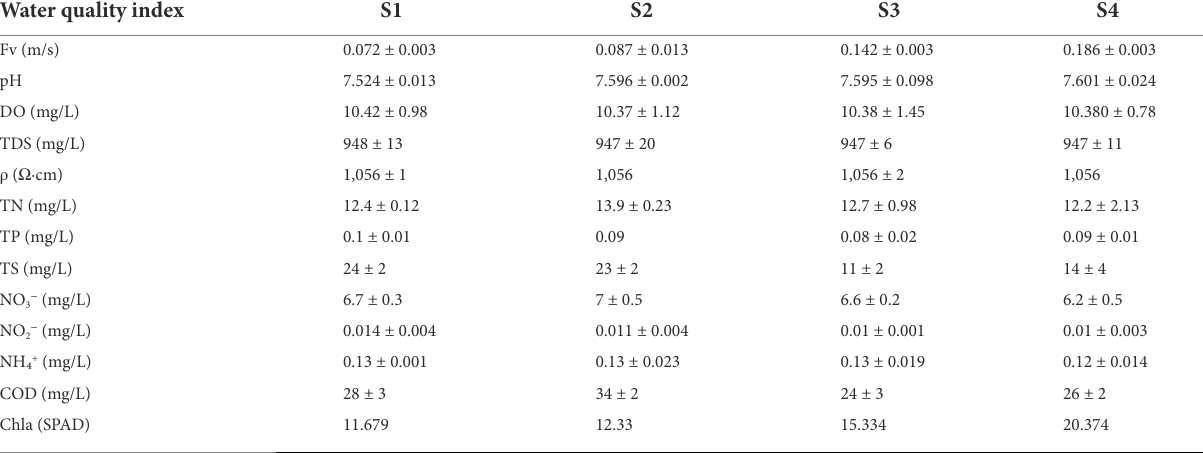
TABLE 1 Water quality index after the restoration of flow in